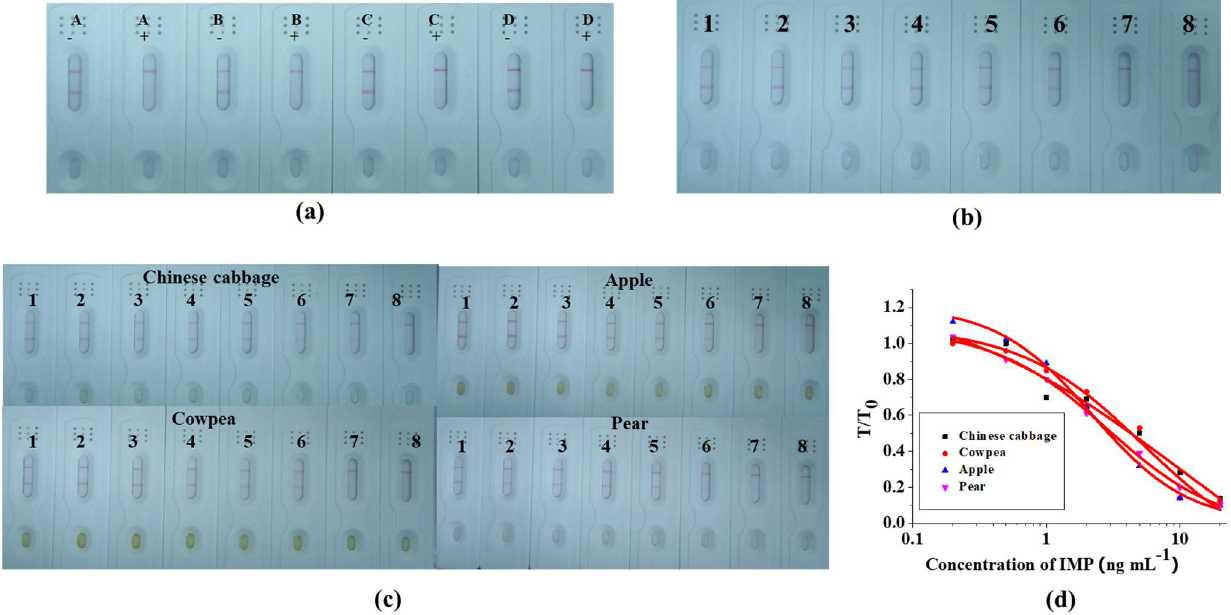
Figure 3. Results of the optimization of the strip test with extra added A = PVP; B = PEG-2000; C = BSA; and D = Rhodasurf ® On-870 in the resuspension buffer ( a ). negative (-) and positive (+) = 5 ng mL −1 . The strip used to detect IMP in 0.01 M PBS ( b ), 1–8 represents concentrations of 0, 0.1, 0.2, 0.5, 5, 2, 5, and 10 ng mL −1 . Result after optimization to determine IMP in Chinese cabbage, cowpea, apple, and pear samples; (1–8) represents concentrations of 0, 0.2, 0.5, 1, 2, 5, 10, and 20 ng mL −1 ( c ). Quantitative curve of binding rate (T/T 0 ) against concentration of IMP ( d ). T = sample containing IMP; T 0 sample without IMP.